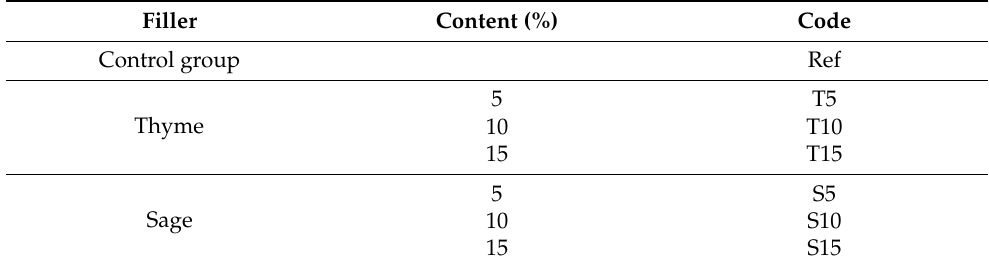
Table 3. Materials’ coding and mass concertation.